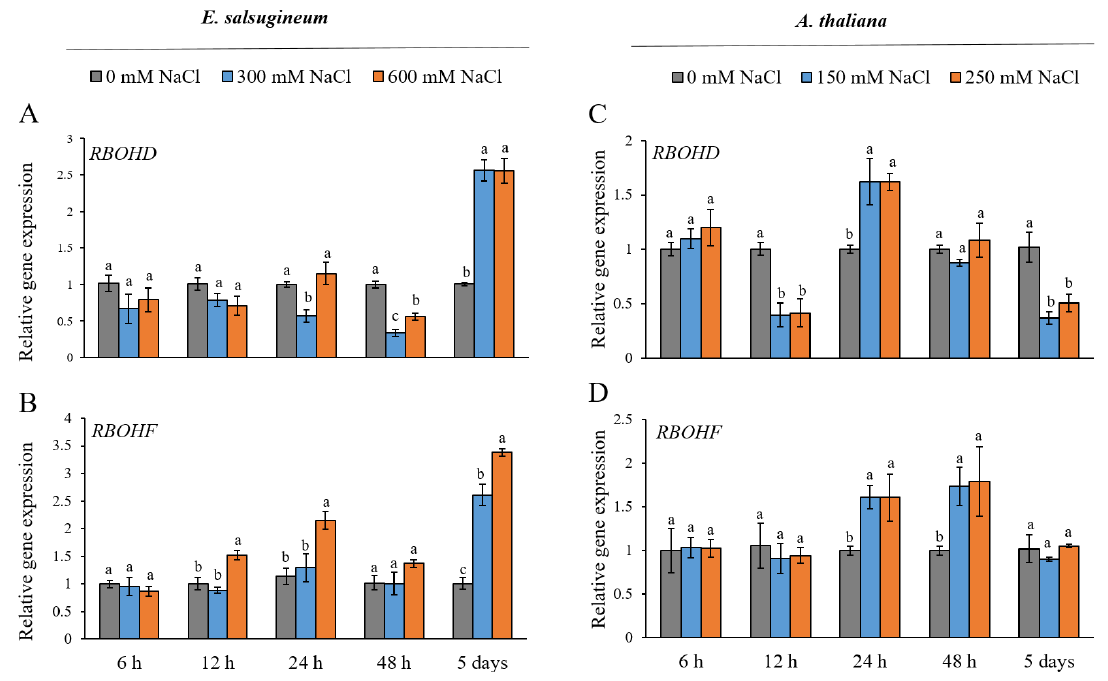
Figure 1. Gene expression patterns of RBOHD ( A , C ) and RBOHF ( B , D ) in leaves of E. salsugineum and A. thaliana under NaCl stress conditions. E. salsugineum plants were exposed to 0, 300, or 600 mM NaCl and A. thaliana plants were exposed to 0, 150, or 250 mM NaCl for 6, 12, 24, or 48 hours or 5 days. Data represent mean ± SE ( n = 3). Different letters illustrate significant differences at p ≤ 0.05.